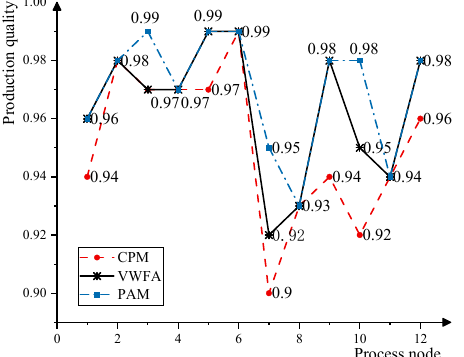
Figure 4. Comparison of scheduling paths of different algorithms.